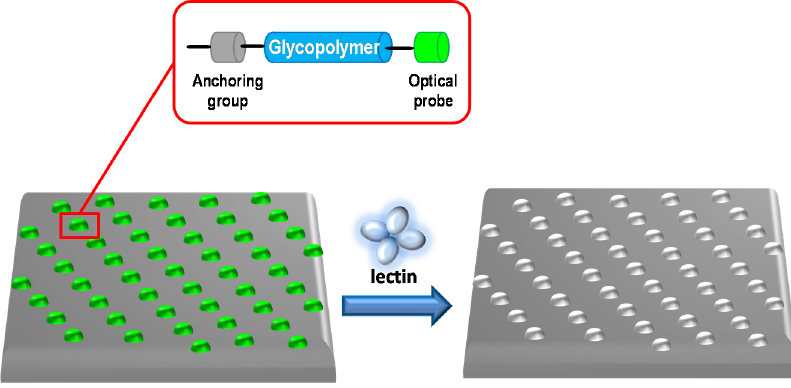
Figure 1. Schematic representation of glycopolymers anchored on chips and their